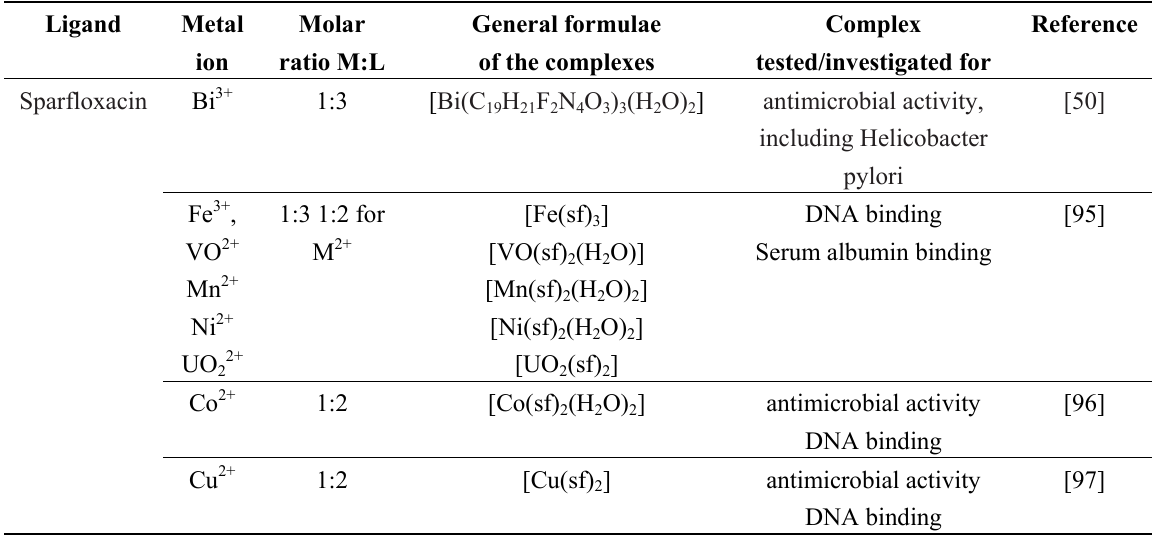
Table 6. Selected chelates of quinolones from third and fourth